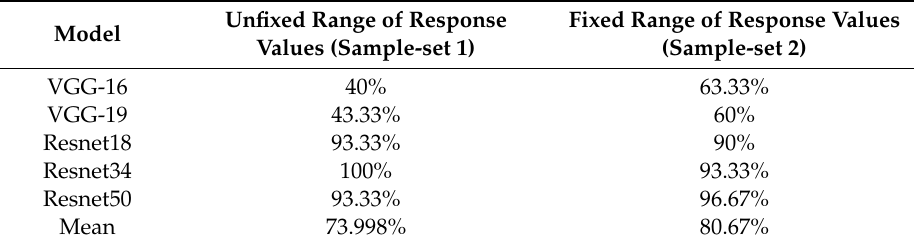
Table 10. Test accuracy for di ff erent classification